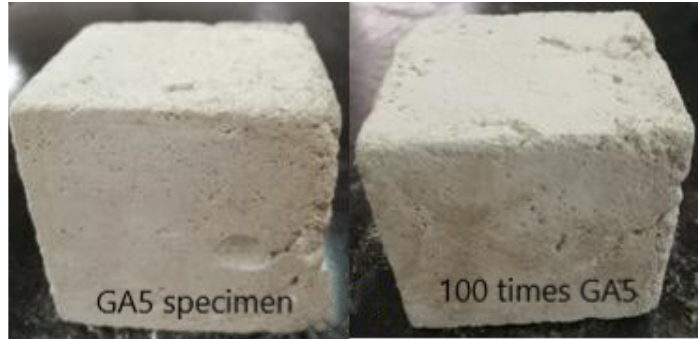
Figure 10. GA5 geopolymer and after 100 times test GA5 geopolymer.